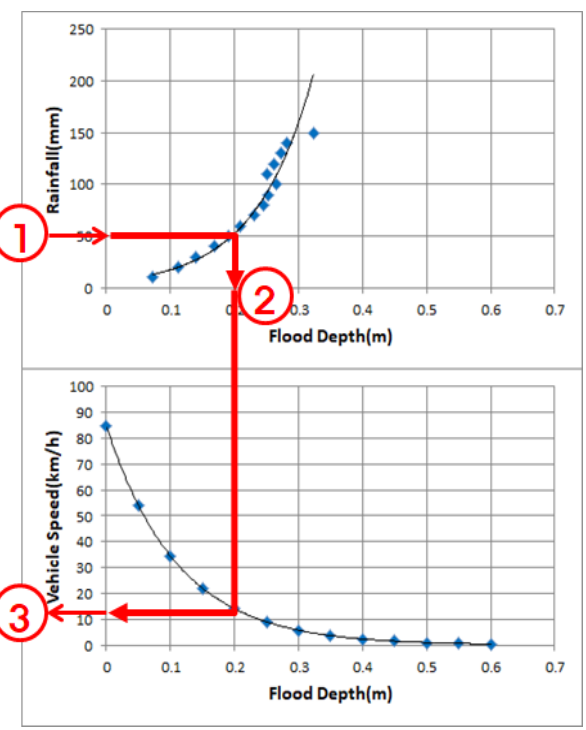
Figure 2. Rainfall – depth – vehicle speed relationship.